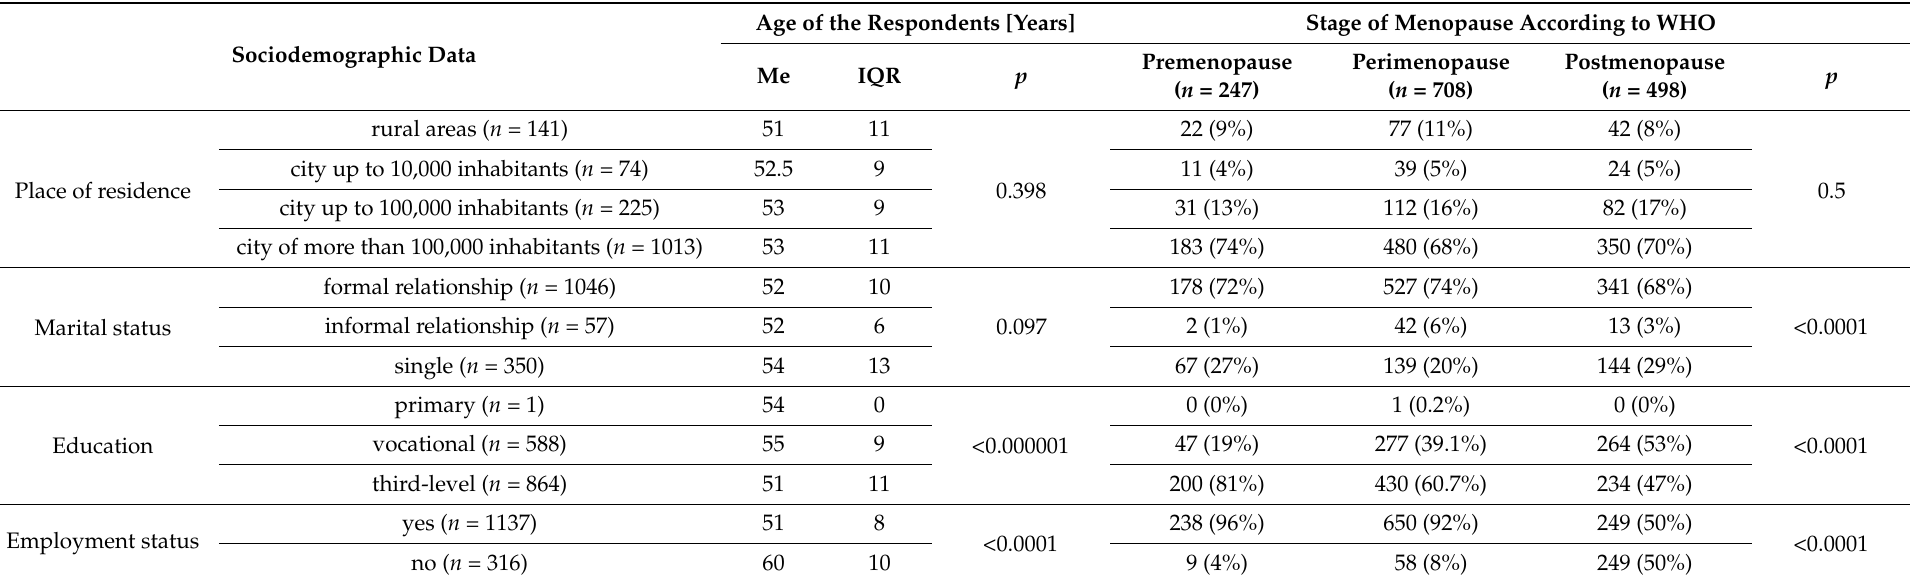
Table 1. The structure of the study sample with regard to socio-demographic data, age, and the stage of menopause according to WHO.